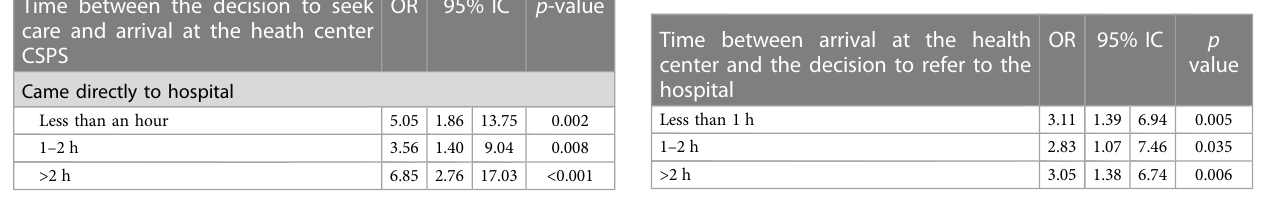
TABLE 4 Association between time to decision to refer and intrapartum fetal